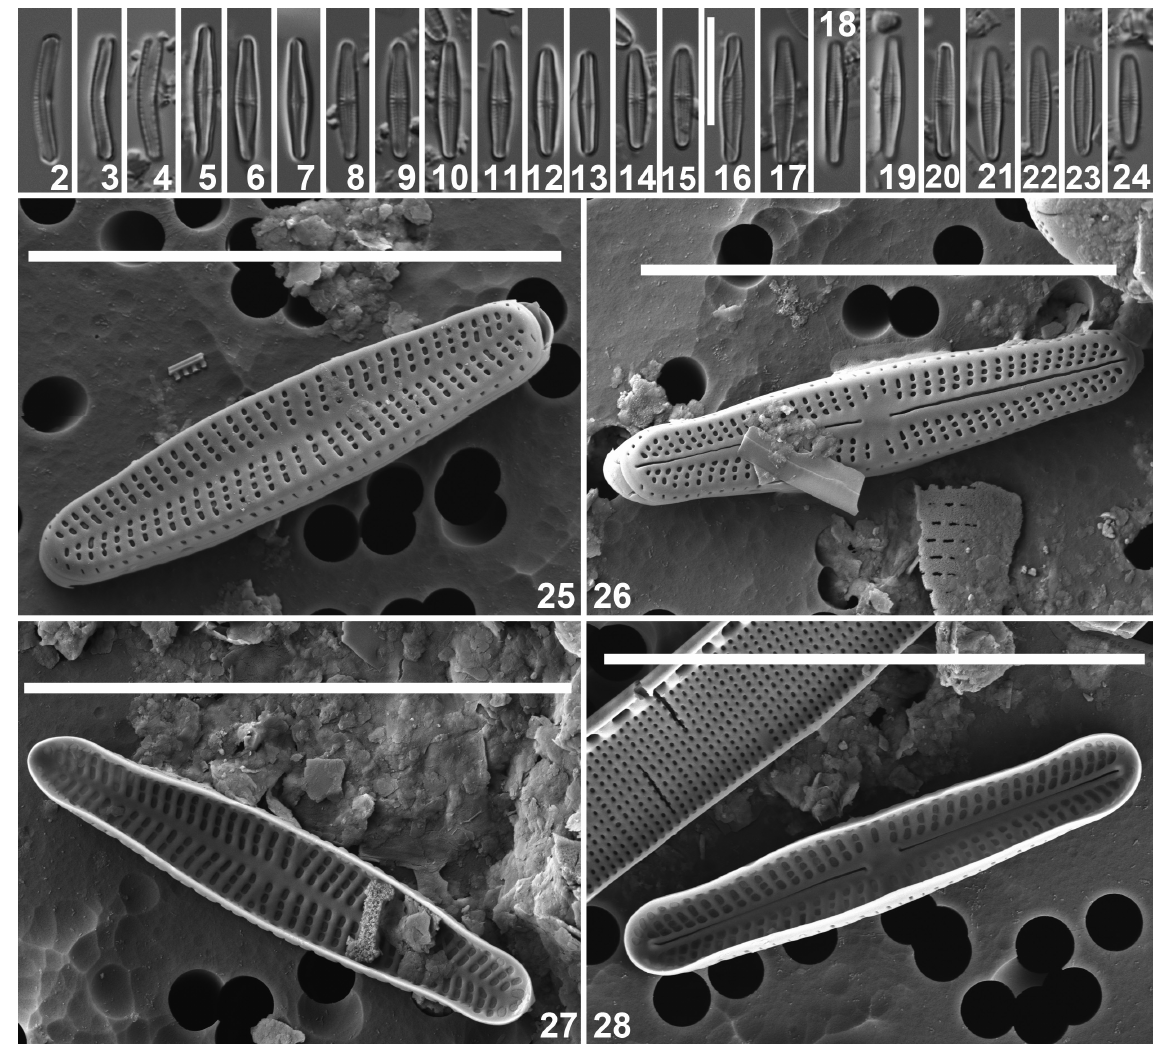
Figs 2-28. Achnanthidium indistinctum Van de Vijver & Kopalová sp. nov. Light and scanning electron micrographs of the type population on Byers Peninsula (Livingston Island). 2-4 . LM views of some frustules in girdle view. 5-15 . LM views of raphe valves. 16-24 . LM views of rapheless valves. 25 . SEM external view of an entire rapheless valve. 26 . SEM external view of an entire raphe valve. 27 . SEM internal view of an entire rapheless valve. 28 . SEM internal view of an entire raphe valve. Scale bars represent 10